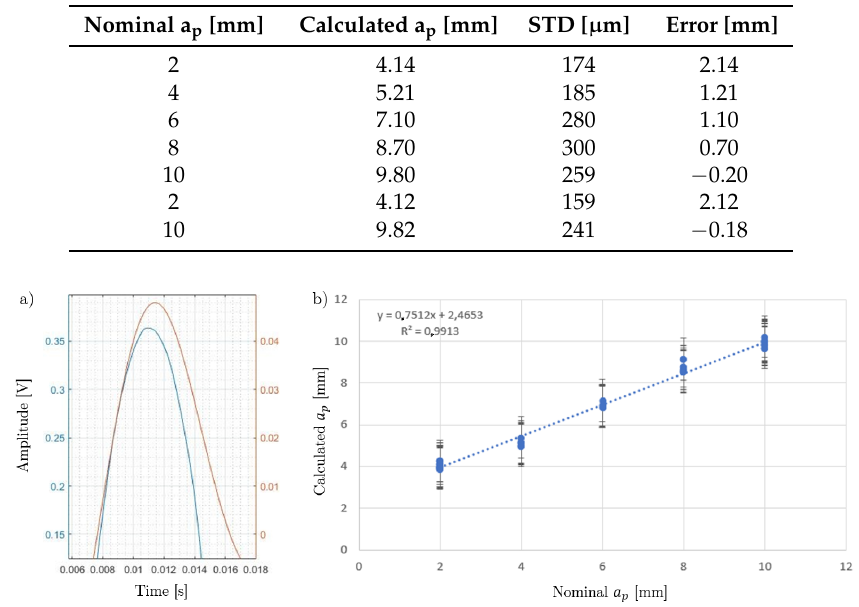
Table 4. Experimental results for the estimated axial depth of cut.